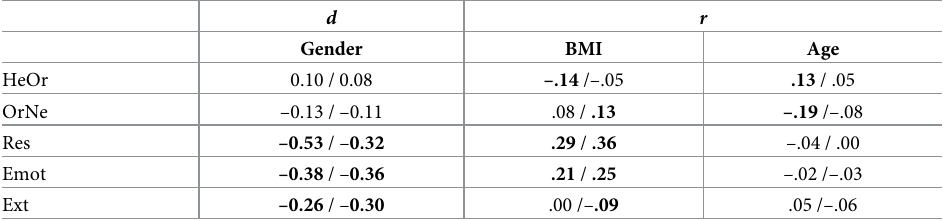
Table 4. Associations of the different item styles with sociodemographic variables.